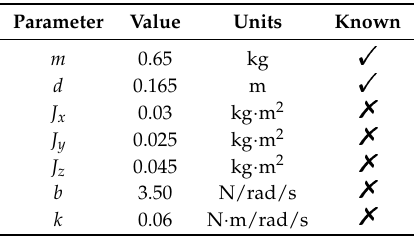
Table 3. Actual parameter